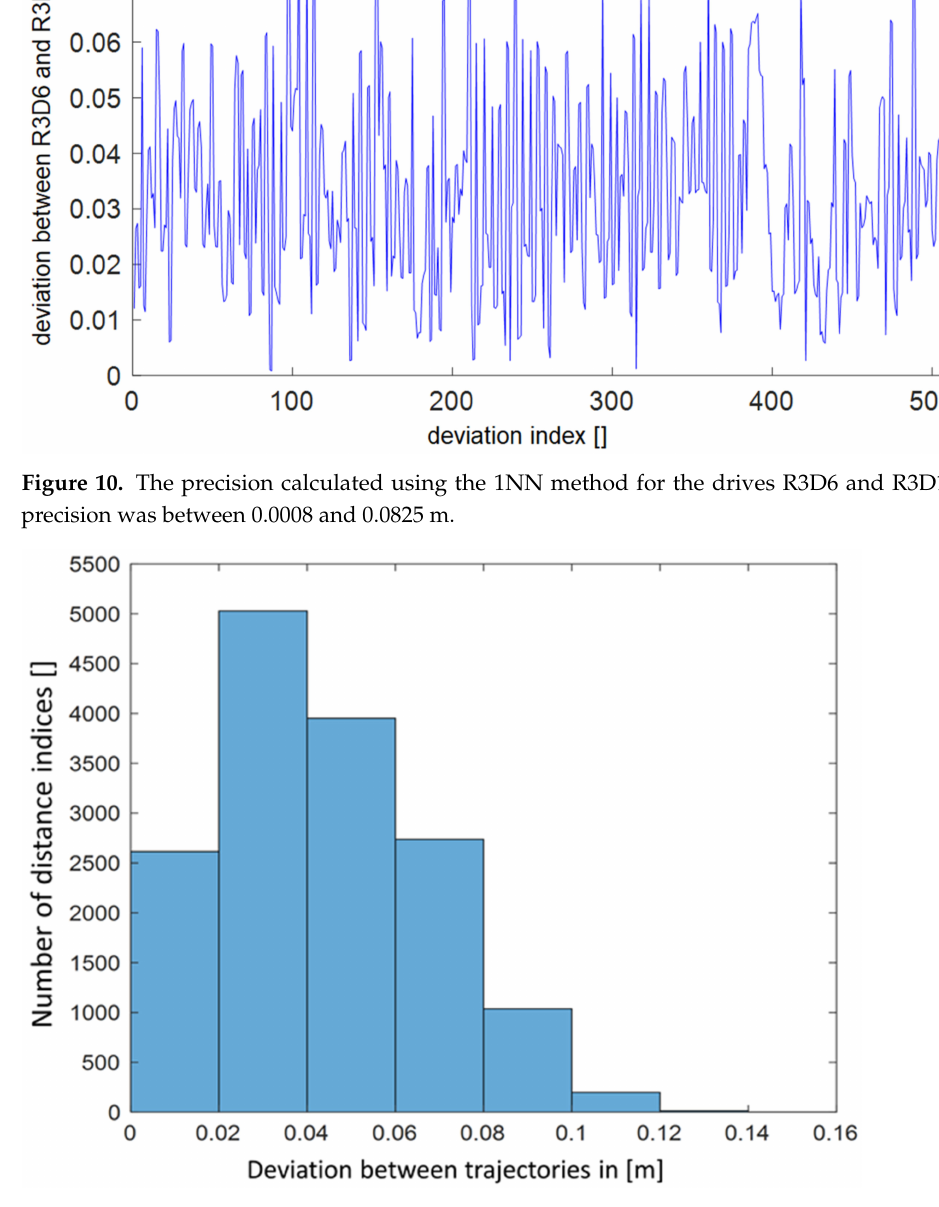
Figure 11. The histogram shows the statistical relationship between the precision of the nine drives taken into account from run 3 in the route section